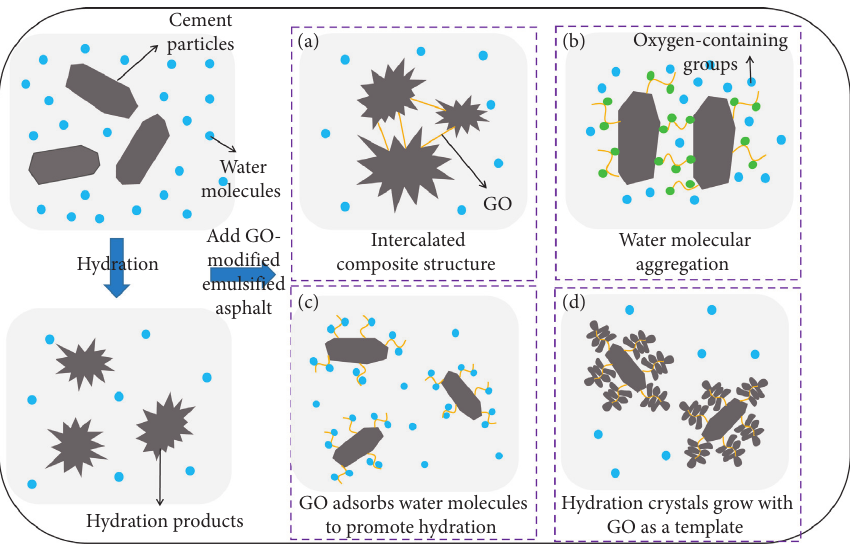
Figure 12: Diagrammatic sketch of interaction between GO and cement emulsified